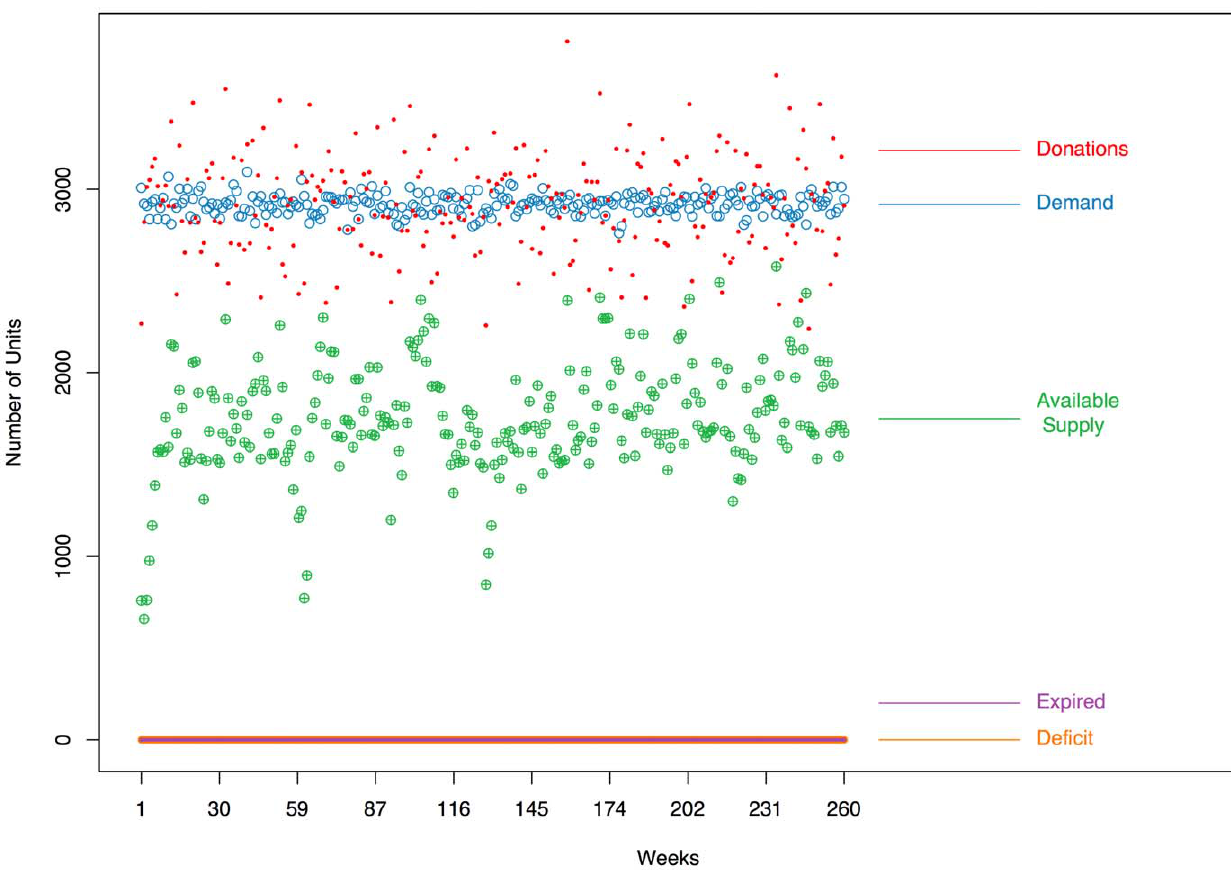
Figure 3. Time series of blood donations, demand, available supply, expired units, and deficit during a ‘‘Normal Period,’’ from one run of the simulator over 260 weeks after a 5 , 000 -week burn-in period (not shown).